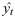
An overview of the inputs and targets to the network in paired cell inpainting, and of our proposed architecture.(A) Inputs and targets to the network. We crop a source cell (green border) and a target cell (orange border) from the same image. Then, given all channels for the source cell, and the structural markers for the target cell (in this dataset, the nucleus and the microtubule channels), the network is trained to predict the appearance of the protein channel in the target cell. Images shown are of human cells, with the nucleus colored blue, microtubules colored red, and a specific protein colored green. (B) Example images from the proteome-scale datasets we use in this study. We color the protein channel for each dataset in green. The CyCLOPS yeast dataset has a cytosolic RFP, colored in red. The NOP1pr-ORF yeast dataset has a brightfield channel, colored grey. The Nup49-RFP GFP-ORF yeast dataset has a RFP fused to a nuclear pore marker, colored in red. The Human Protein Atlas images are shown as described above in A. (C) Our proposed architecture. Our architecture consists of a source cell encoder and a target marker encoder. The final layers of both encoders are concatenated and fed into a decoder that outputs the prediction of the target protein yt^. Layers in our CNN are shown as solid-colored boxes; we label each of the convolutional layers (solid grey boxes) with the number of filters used (e.g. 3x3 Conv 96 means 96 filters are used). We show a real example of a prediction from our trained human cell model given the input image patches in this schematic.